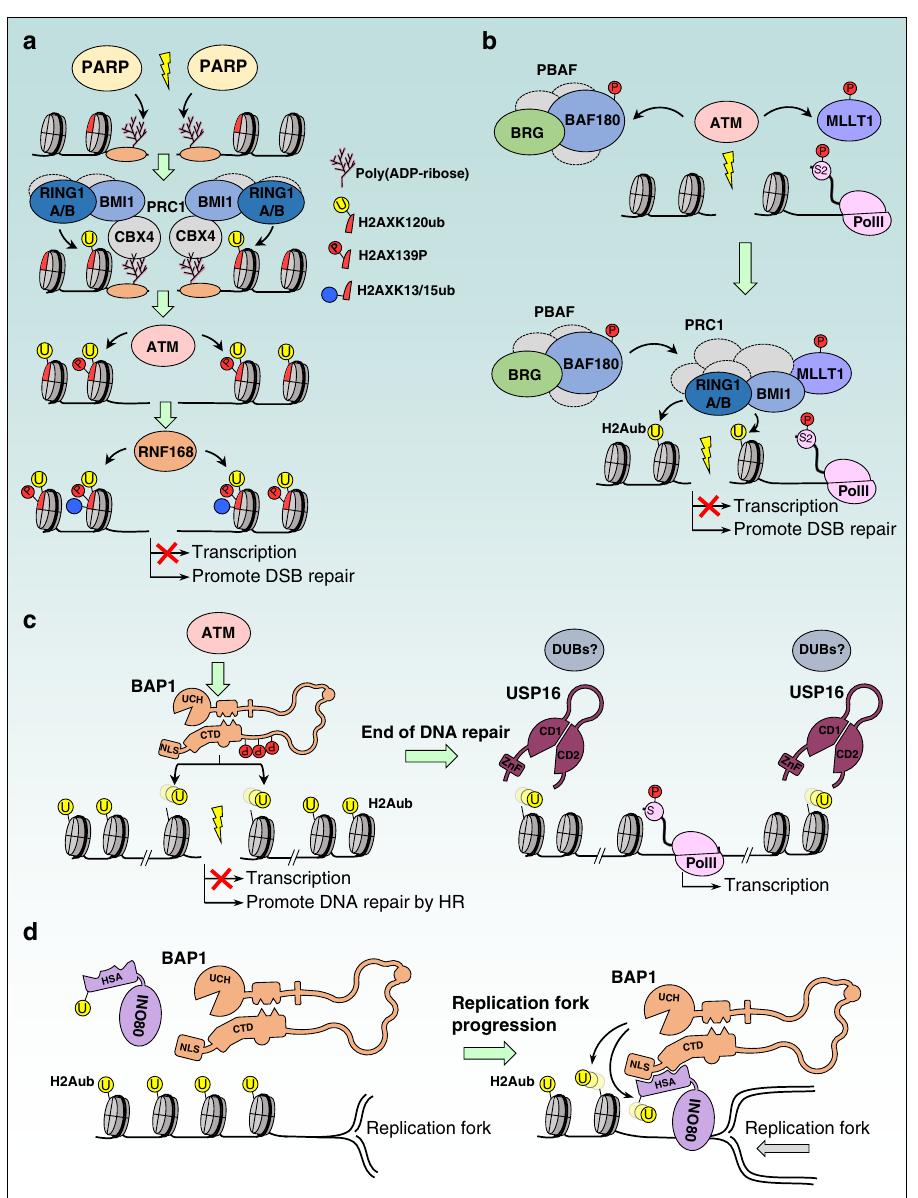
Fig. 6 Involvement of H2Aub in DNA double strand break signaling and replication fork progression. a Induction of DNA double strand breaks (DSBs) induces a rapid recruitment of PARP to DNA damage sites and subsequent protein poly(ADP-ribosyl)ation. Poly(ADP-ribose) serves as an anchor for the PRC1 complex, through its CBX4 subunit which leads to the recruitment of PRC1 to DNA damage site and ubiquitination of the histone variant H2AX. This ubiquitination event induces a more ef fi cient recruitment of ATM and phosphorylation of H2AX ( γ H2AX), a hallmark of the DNA damage response. This in turn leads to the recruitment of RNF168 with catalyzes H2AXK13/K15 ubiquitination. Altogether, this cascade of posttranslational modi fi cations leads to effective recruitment of the DNA repair machinery and inhibition of transcription. b Speci fi c recruitment of the PRC1 complex to DNA DSB sites could be enhanced through interaction between BMI1 and the phosphorylated form of the transcription elongation factor MLLT1. Phosphorylation of PBAF also promotes the recruitment of the PRC1 complex to the site of DNA damage. c BAP1 is phosphorylated following DNA damage and is also recruited to DSB site to promote homologous recombination (HR). BAP1 appears to deubiquitinate H2Aub only near the DSB site, likely promoting DNA-end resection. Once the repair process is completed, the deubiquitinase USP16 or other DUBs could remove H2Aub mark more widely, allowing normal gene transcription. CD1 and CD2: the two parts of the catalytic domain. d During DNA synthesis, the chromatin-remodeling factor INO80 is protected from proteasomal degradation by BAP1. On the other hand, BAP1 deubiquitinates H2A and promotes coordinated DNA replication. HSA, Helicase-SANT associated domain. Ubiquitination is shown by the yellow circle, and phosphorylation by the red